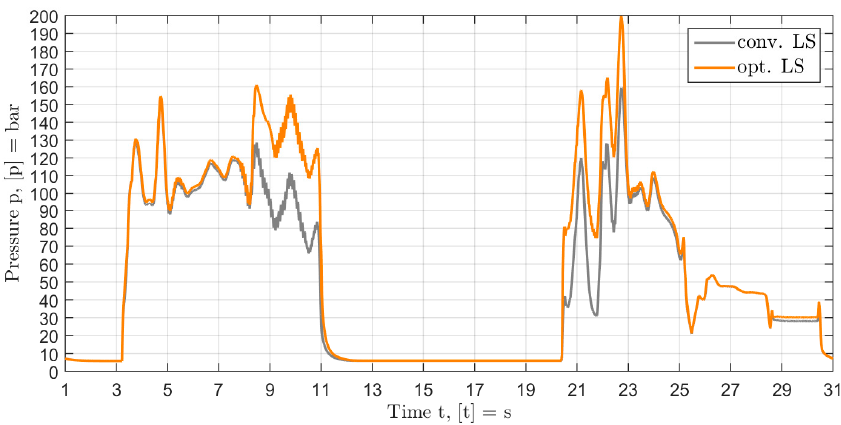
Figure 22. Comparison conv./opt. LS system: LS pressure level p LS,1 in Section 1. [9] Reproduced with permission from the publisher.